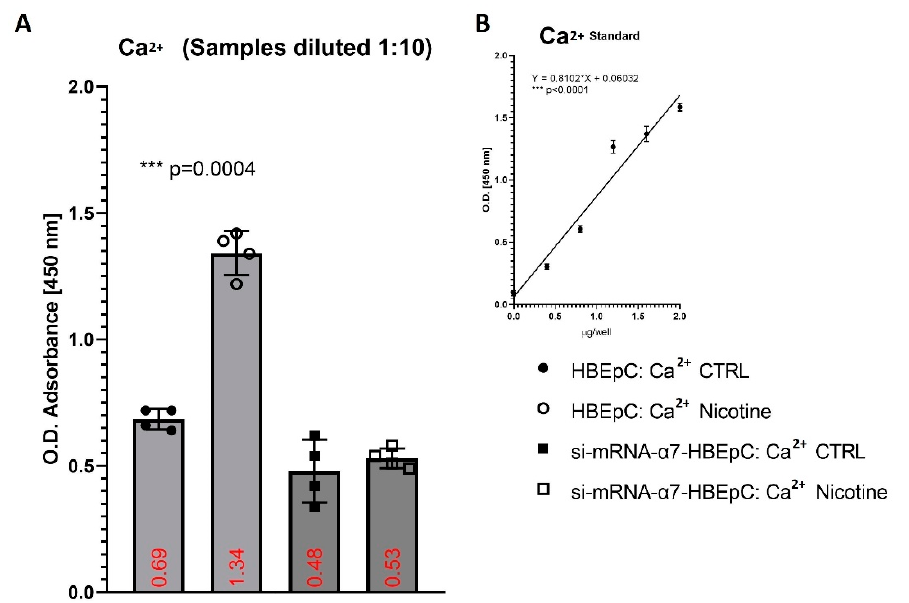
Figure 4. Evaluation of intracellular Ca 2+ after exposure to nicotine for 48 h in HBEpC and/or si-mRNA- α 7-HBEpC. ( A ): ELISA experiments; ( B ): regression equation linearity, performed with Prism. Statistical significance is analyzed with one-way ANOVA with multiple-comparison and post hoc test with Bonferroni correction. Experiments are performed at least two times in triplicate.